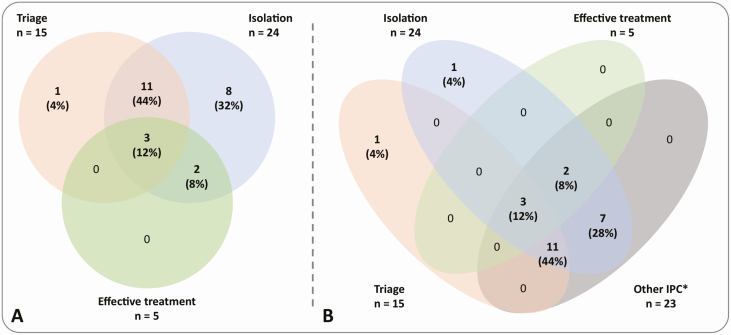
Venn diagrams showing overlap between interventions implemented in the 25 studies included. A, Overlap between the 3 interventions of interest. B, Overlap between the 3 interventions of interest and other IPC measures implemented. *Includes administrative, personal protective, and environmental IPC measures. Figure developed using Venny v2.1 [23], Inkscape (https://inkscape.org/), and GIMP (https://www.gimp.org/) software. Abbreviation: IPC, infection prevention and control.